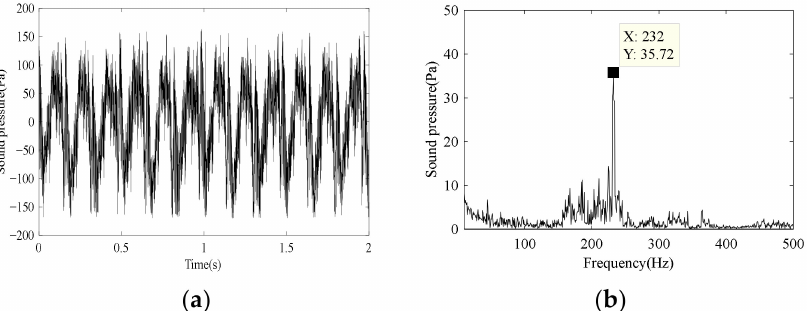
Figure 6. Primary signal of the time-domain and the corresponding frequency spectrum of sound pressure: ( a ) Primary signal of the time-domain; ( b ) The corresponding frequency spectrum.